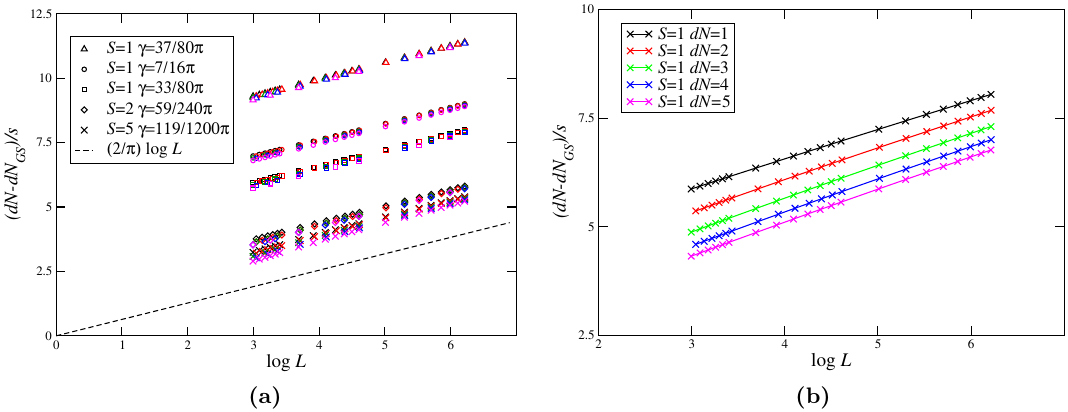
Figure 6 . ( dN − dN GS ) /s vs. log( L ) on the self-dual line α = π/ 2 . Different symbols indicate different combinations of S and γ as labeled in the legend. (a) Collapse of data for spin- S states and anisotropies γ . π/ 2 S corresponding to the continuous part of the conformal spectrum with different dN (encoded by coloring: black dN = 1 , red dN = 2 , green dN = 3 , blue dN = 4 and magenta dN = 5 ). (b) Lifting of this degeneracy w.r.t. dN for the states in the S = 1